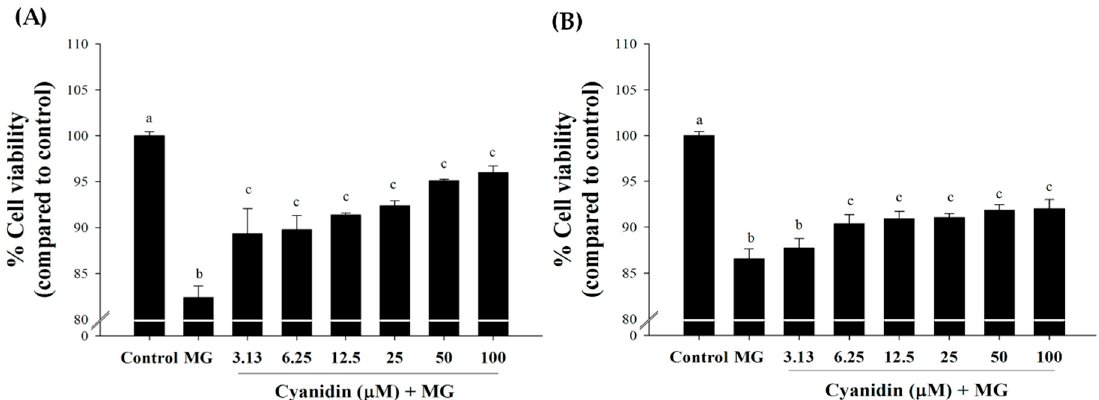
Figure 2. E ff ect of cyanidin and its treatment with 500 µ M methylglyoxal (MG) on cell viability. ( A ) Cotreatment of cyanidin (3.13–100 µ M) and MG decreased cytotoxicity during 12 h. ( B ). Pretreatment with cyanidin (6.25–100 µ M) for 12 h decreased cytotoxicity during 12 h of MG exposure. Results are presented as mean ± SEM ( n = 3). The groups that do not share a common letter are significantly di ff erent ( p < 0.05).